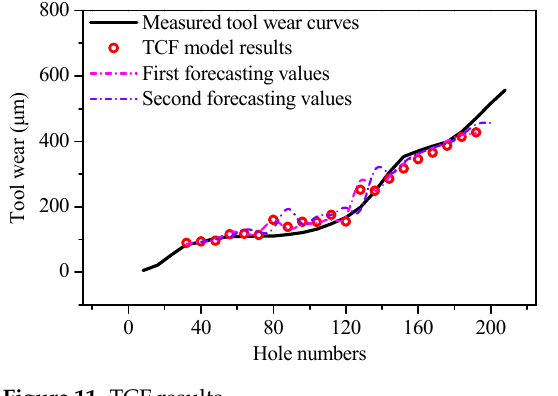
Figure 11. TCF results.